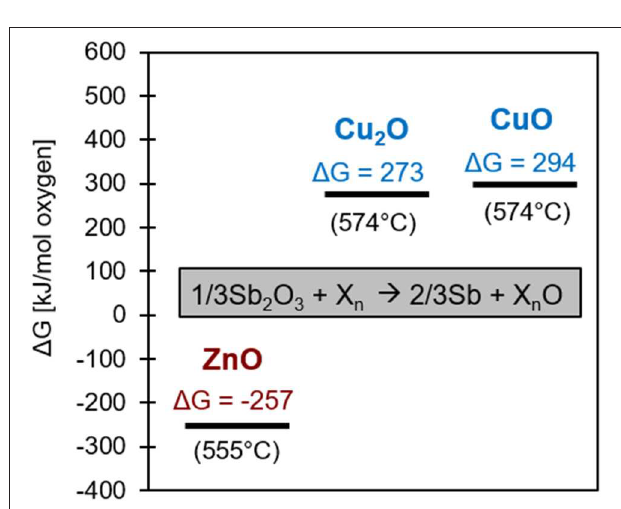
FIGURE 4 | Free energy diagram of the three possible ways Zn or Cu can reduce Sb 2 O 3 . The adjustment of 1 G 0 , the reference free energy for each specific oxide of Cu or Zn, to 1 G considers thermodynamic activity for the 4 at% alloys at the healing